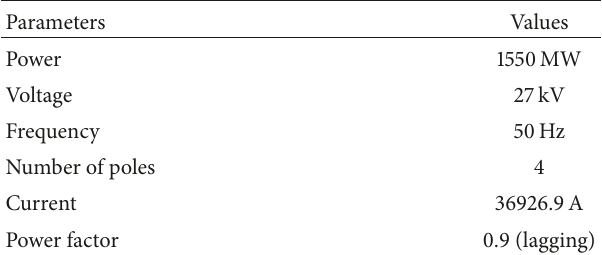
Table 1: Parameters of the 1550 MW nuclear generator.